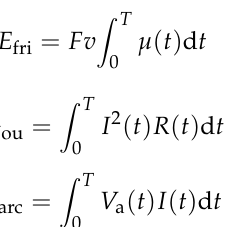
Figure 15. The three contact areas and contact area sets on the surface of the friction pair. Under current-carrying friction and wear, A r is the area of actual contact pressure, and A c is responsible for the current conduction. Therefore, the coupling effects of stress concentration, current density concentration, and heat concentration will be generated on the contact belt, and a large amount of friction heat, contact resistance heat, and arc heat will be generated. The three heat effects affect the wear mechanism of conductive materials [132]. From the angle of energy [35], the heat consumed by friction heat is shown in Equation (1), and the energy consumed by contact resistance heat is shown in Equation (2). The energy consumed by arc heat is shown in Equation (3), where F is the average load, v is the sliding speed, µ is the friction coefficient, T is the total sliding time, I is the current, R is the contact resistance, and V a is the potential of the arc generated between the friction